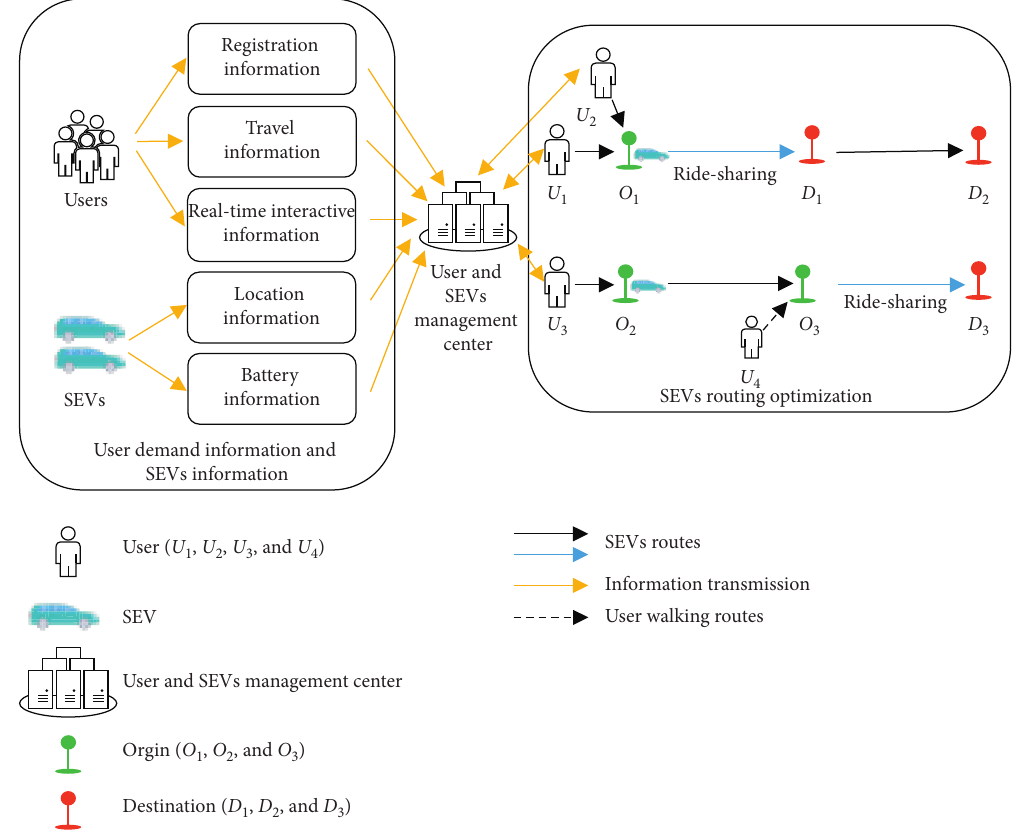
Figure 1: The schematic diagram of operation principle of